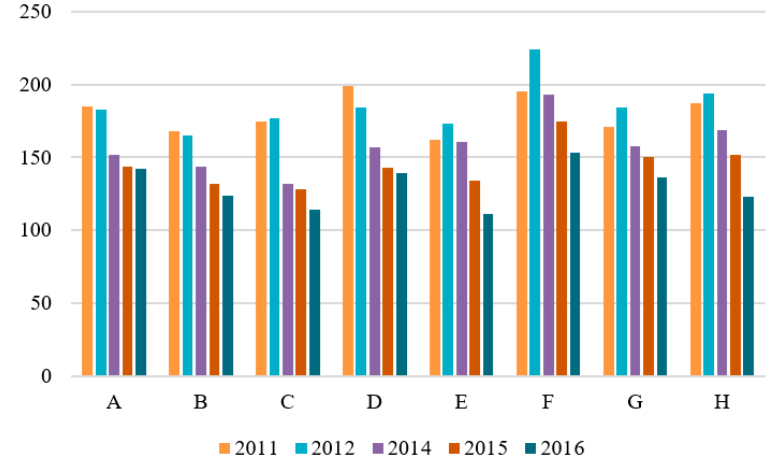
Figure 10. The average value of the vehicle unloading time rate (minutes) in the analysed road freight transport enterprises in the years 2011–2016.